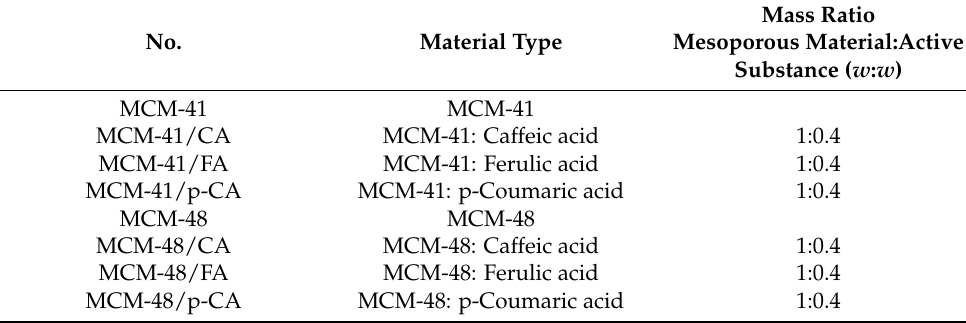
Table 1. Type of polyphenol-loaded mesoporous